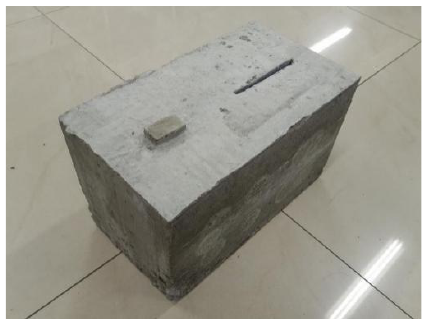
Figure 6. Concrete block II.